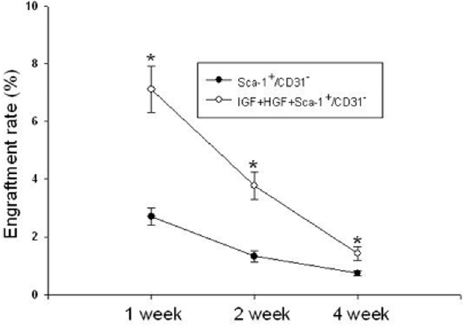
Figure 2. Effects of IGF + HGF supplementation increase the engraftment rates of transplanted Sca-1 + /CD31 2 cells. The y -axis indicates the number of X-gal and DAPI double stained cells in the whole heart relative to total cell numbers injected. Data were acquired at 1, 2, and 4 weeks after transplantation (n=6, P , 0.01 vs Sca-1 + / CD31 2 cells without HGF + IGF). X-gal, 5-bromo-4-chloro-3-indolyl- b -D- galactoside. DAPI, 4, 6-diamidino-2-phenylindole.